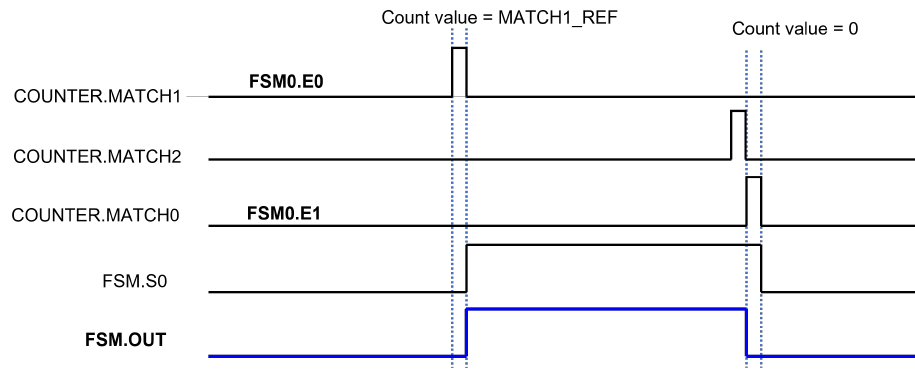
Figure 9. Timing chart of counter and FSM.